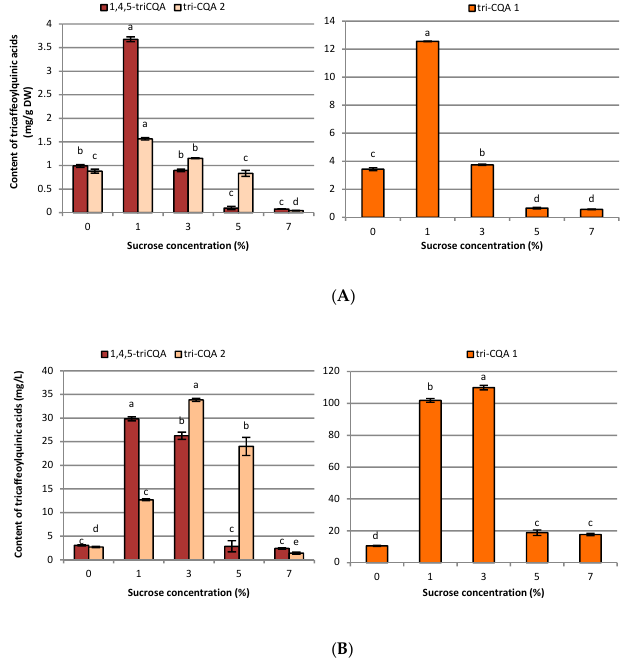
Figure 4. Effect of sucrose concentration (0–7%) on dicaffeoylquinic acid derivative contents in ( A ) mg g − 1 DW and ( B ) mg L − 1 in R. carthamoides transformed roots cultured in 50 mL of liquid WPM medium in a 300 mL Erlenmeyer flask, in light conditions (16/8-h light/dark photoperiod) on a rotary shaker at 80 rpm. The results are means values ± SE ( n = 9). Different letters for the same metabolite signify significant differences between the sucrose concentrations ( p < 0.05). 3,5-diCQA-3,5- di- O -caffeoylquinic acid; 4,5-diCQA-4,5-di- O -caffeoylquinic acid; 1,3-diCQA-1,3-di- O -caffeoylquinic; 3,4-diCQA-3,4-di- O -caffeoylquinic; 1,5-diCQA-1,5-di- O -caffeoylquinic.